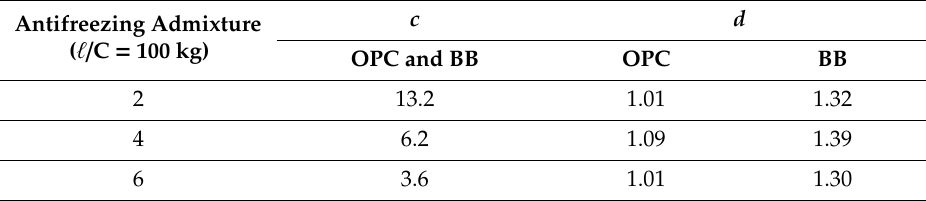
Table 7. Experimental coe ffi cients (c,